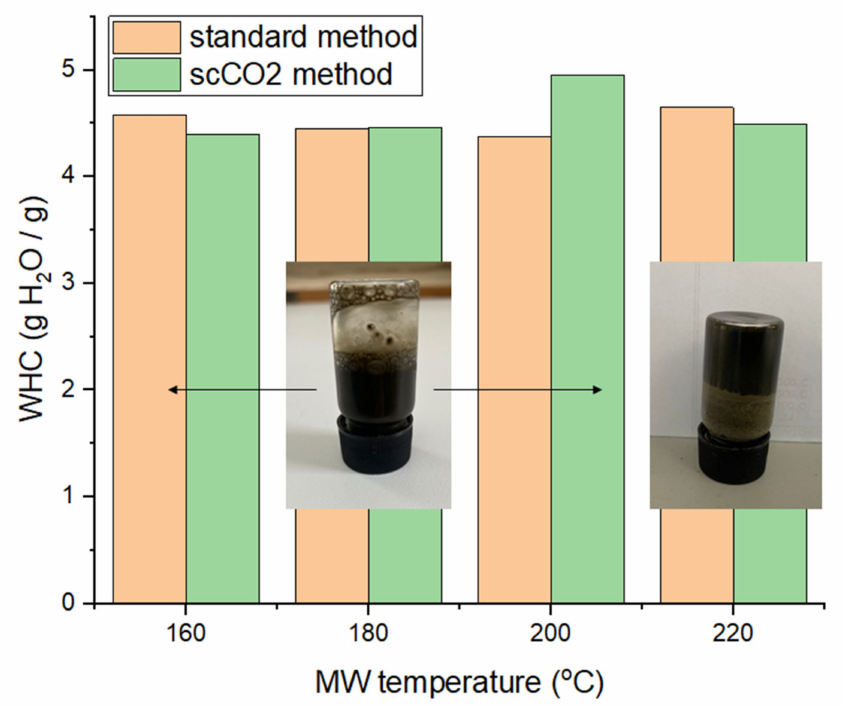
Figure 10. Water holding capacities (WHC) of MFC of both standard and scCO 2 methods. NB. ‘Standard’ refers to without any scCO 2